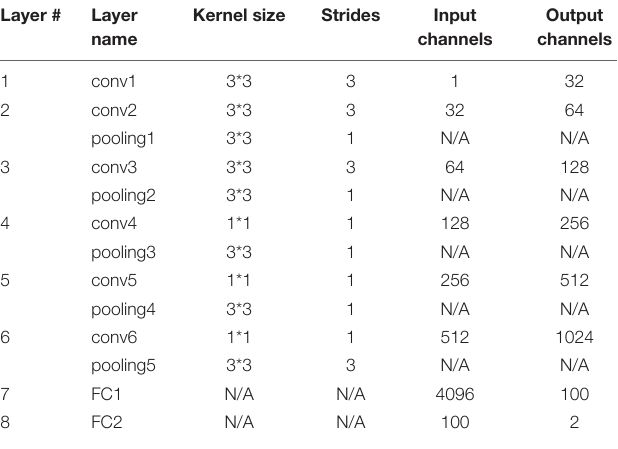
TABLE 3 | Detailed hyper-parameters of base classifiers of the CNN-EL approach advocated